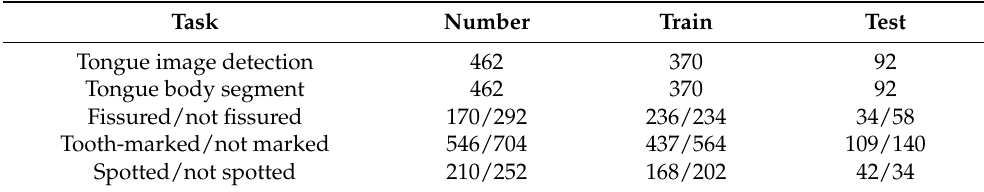
Table 3. The number of training and testing data for each